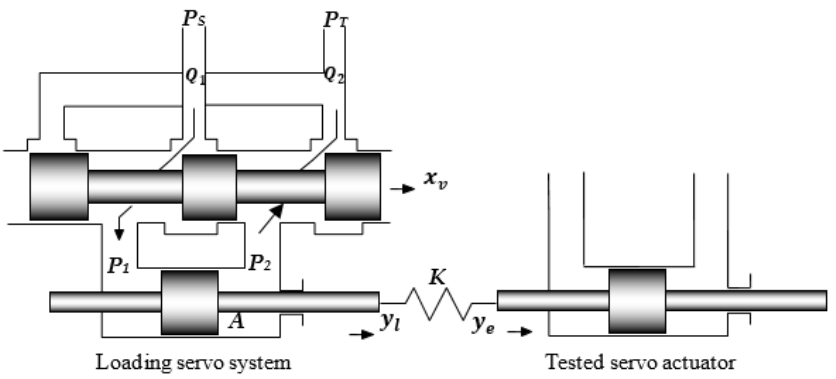
Figure 3. Schematic diagram of electro-hydraulic servo loading system.